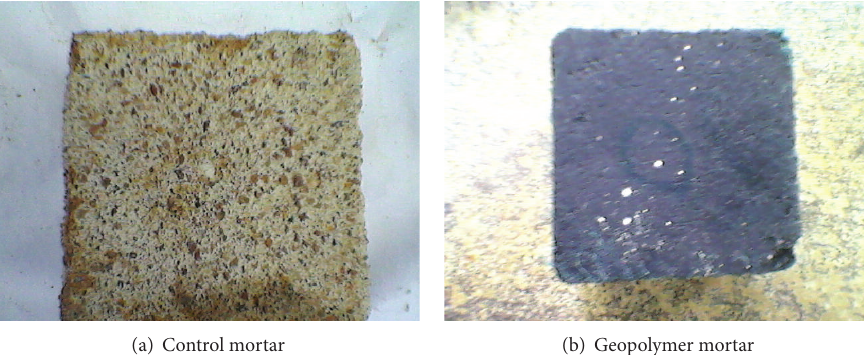
Figure 12: Photograph of specimen immersed in 5%